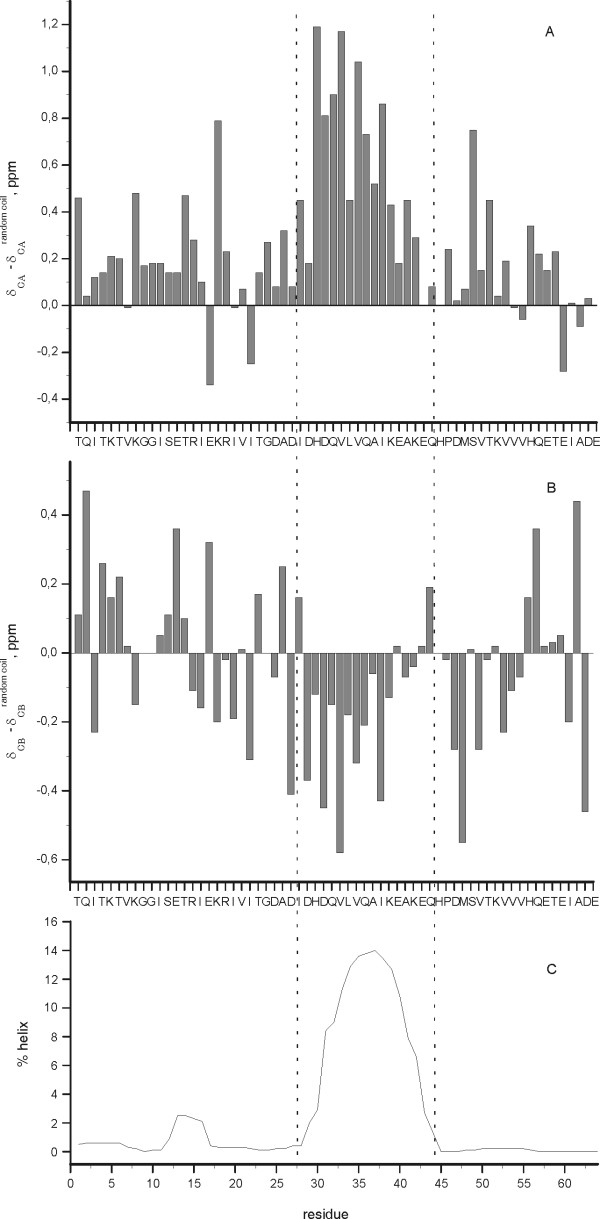
Tendency of 4.1R-CTD64 to adopt an α-helix conformation. A: Conformational Δδ13Cα (Δδ13Cα = δ13Cα, experimental- δ13Cα, random coil, ppm) chemical shifts as a function of sequence. Positive values indicate α-helix structure. B: Conformational Δδ13Cβ (Δδ13Cβ = δ13Cβ, experimental- δ13Cβ, random coil, ppm) chemical shifts as a function of sequence. Negative values indicate α-helix structure. C: Theoretical prediction of helical percentage at 5°C and pH 5.0 by AGADIR [23] as a function of residue number.